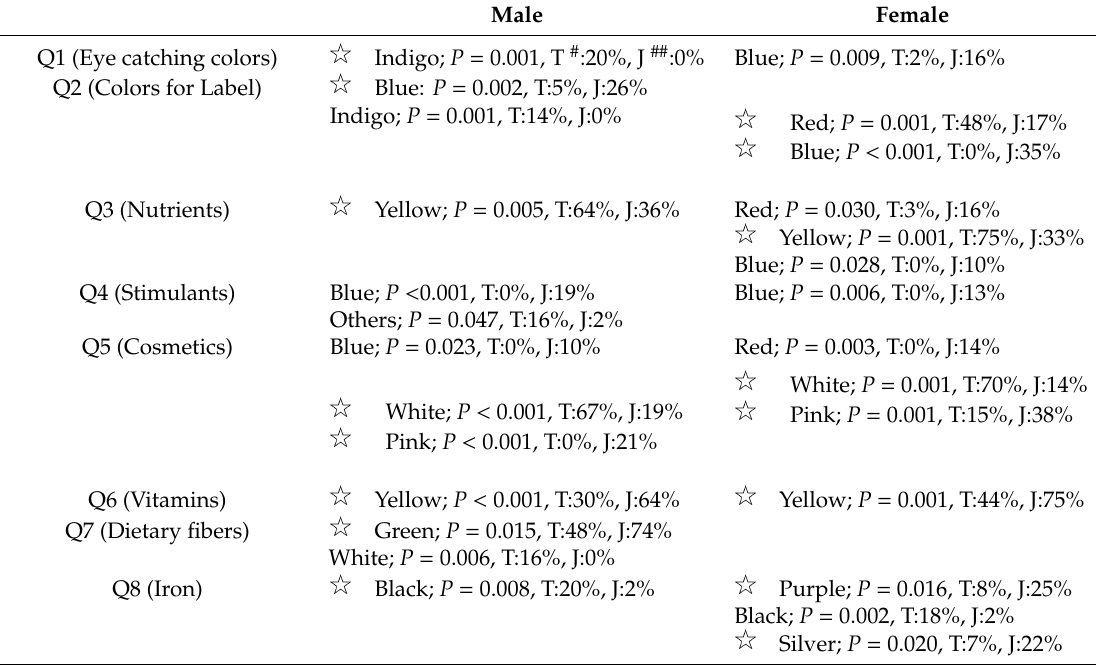
Figure 1. Distributions of respondents on colors in the energy drink-associated questionnaires; ( A ) eye-catching color in the energy drinks section, ( B ) color which comes to mind for an energy drink label, ( C ) color associated with nutrients, ( D ) color associated with stimulants, ( E ) color associated with cosmetic, ( F ) color associated with vitamins, ( G ) color associated with dietary fibers, and (H) color associated with iron. Each column represents the average of percentage frequency ([the number of respondents who selected each color] × 100/[the total number of corresponding respondents]) for the four groups (Taiwan ‐ Male, Taiwan ‐ Female, Japan ‐ Male, Japan ‐ Female). Table 2. Inter ‐ country comparison by Fisher ′ s exact test.